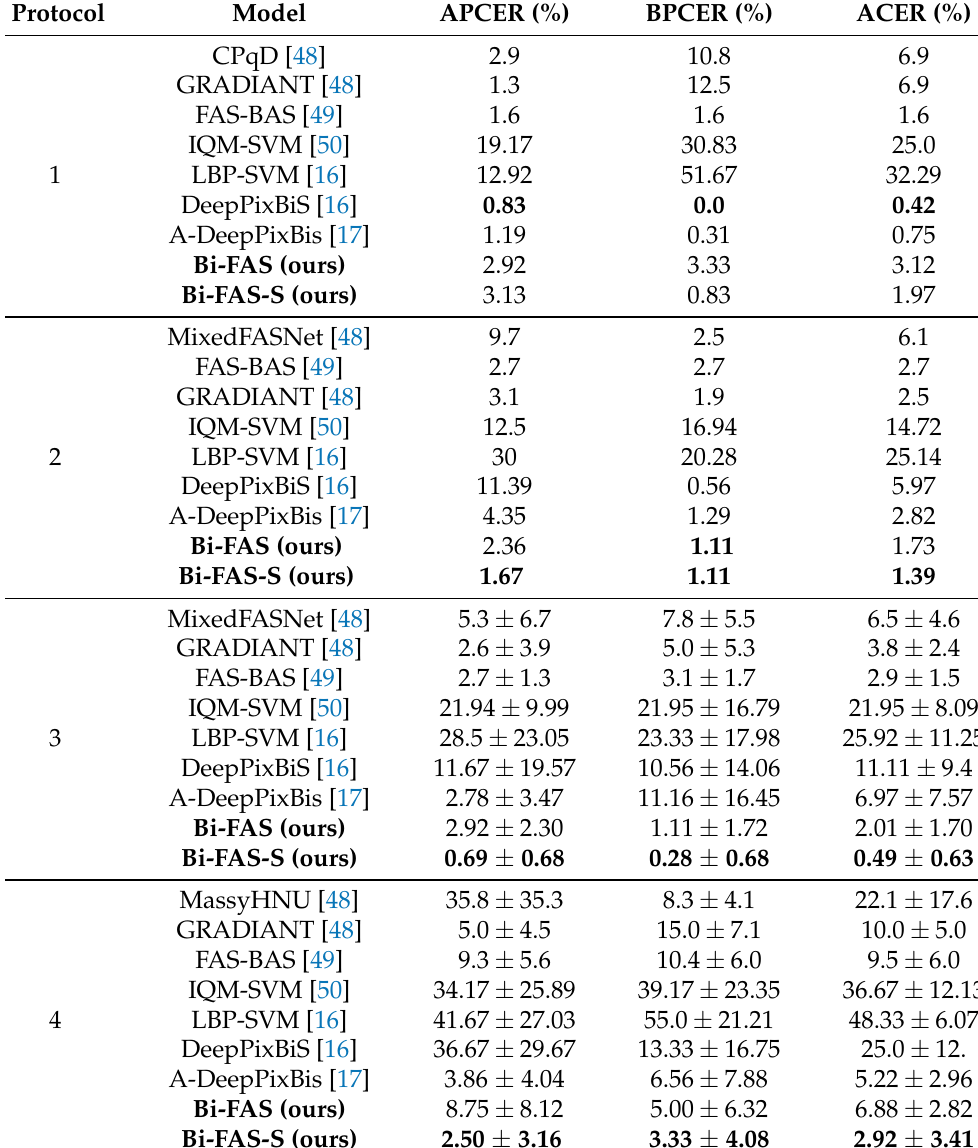
Table 3. Metrics of our proposed models compared with other algorithms on OULU-NPU [14] for intra-dataset